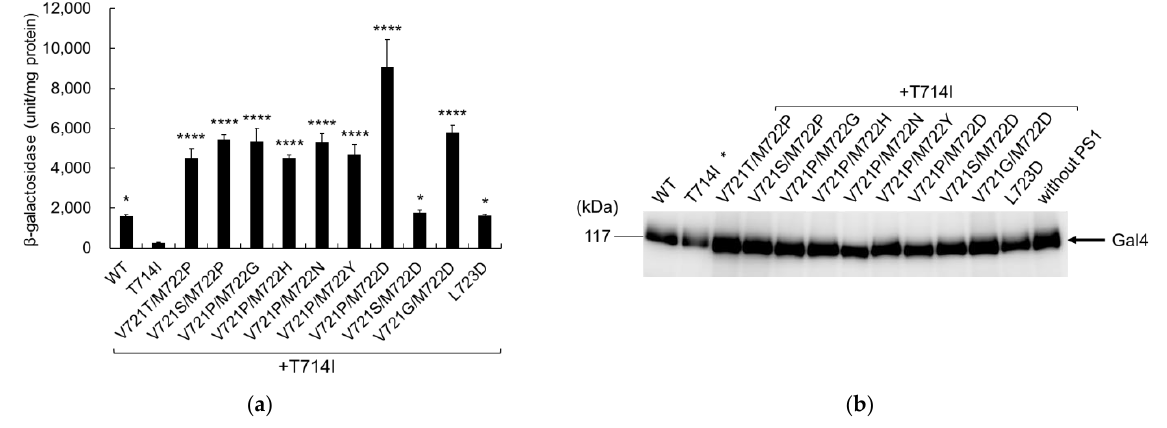
Figure 3. β-Galactosidase activity of secondary mutations in APP T714I. Wild-type (WT) or mutant APPC55-Gal4p was introduced into yeast with PS1, NCT, FLAG-Pen2, and Aph-1aL-HA. ( a ) β -Galactosidase activity was assayed for each cell expressing WT or mutant APPC55-Gal4p. β -Galactosidase activity was normalized to that of the control cells without PS1 (56 units/mg protein). Representative results from three independent assays are shown with standard deviations. Asterisks indicate p < 0.0001 (****) or p < 0.05 (*) compared to T714I; ( b ) Expression of WT or mutant APP in yeast. Cell lysates from the WT or mutant APP were analyzed using immunoblot analysis and an antibody against the activation domain of Gal4. The arrow indicates the position of Gal4. An asterisk indicates that this particular lane (T714I) is not characteristic. The expression level of APP T714I is similar to WT (Supplementary Figure S3).